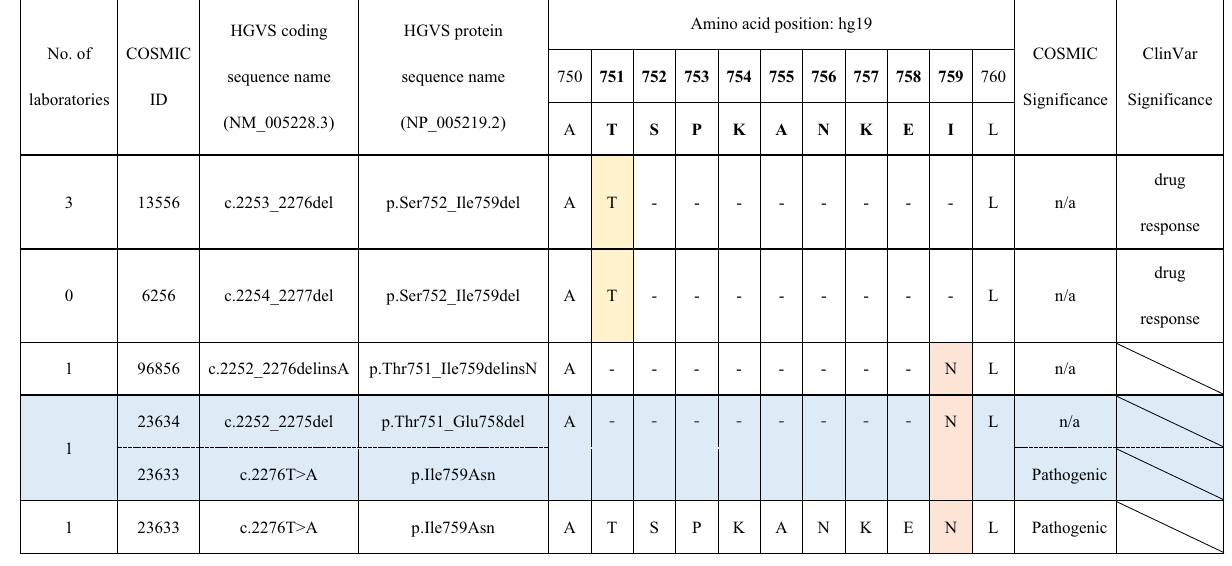
Table 2. Deletion variant in EGFR exon 19 in Patient 3. The variant results obtained from NGS and Sanger sequencing (Supplementary Fig. 4) are summarized. Five types of variants were reported. Deletion variants identified by laboratories were slightly different. However, the correct variant identification is COSMIC ID 96856 or ID 23634 + 232633, which causes deletion of 8 amino acids and a Thr to Asn amino acid substitution, resulting in a possibly pathogenic variant. HGVS: Human Genome Variation